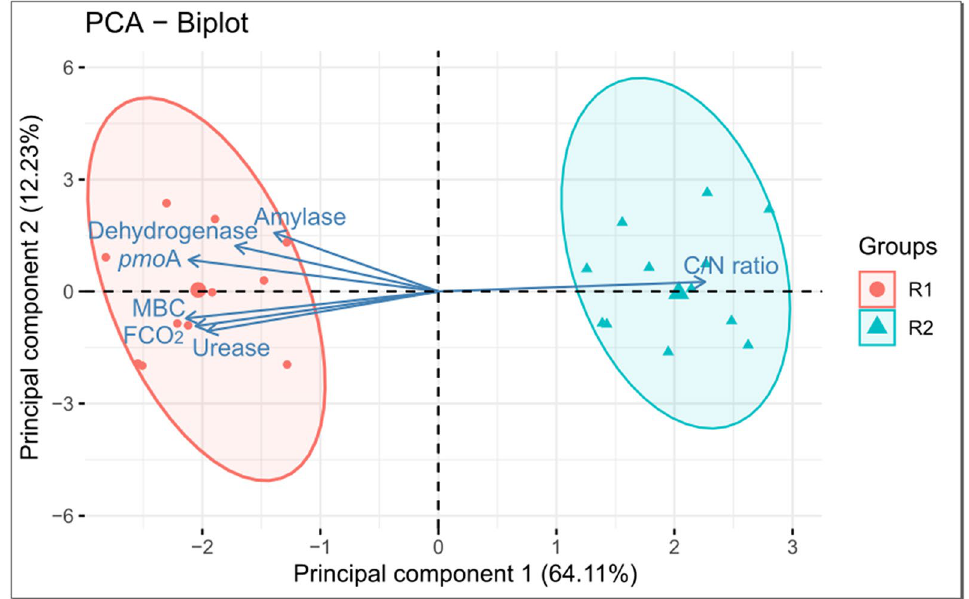
Figure 5. Biplot showing the assessed soil attributes and regions. Amylase = enzymatic activity of amylase; Dehydrogenase = enzymatic activity of dehydrogenase; pmo A = pmo A functional gene; MBC = microbial biomass carbon; Urease = enzymatic activity of urease; FCO 2 = soil CO 2 emission. Principal components were processed using the package ggplot2 and factoextra in the software R version 3.6.3 49 (https:// cran.r- proje ct. org/ bin/ windo ws/ base/ old/3. 6.3/).